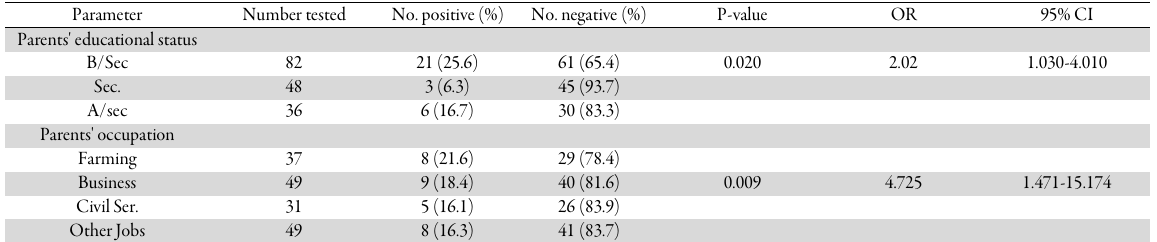
Table 2. Prevalence of Rotavirus group A infection in diarrheic children in relation to parents’ educational status and occupation in Yobe state, Nigeria Parameter